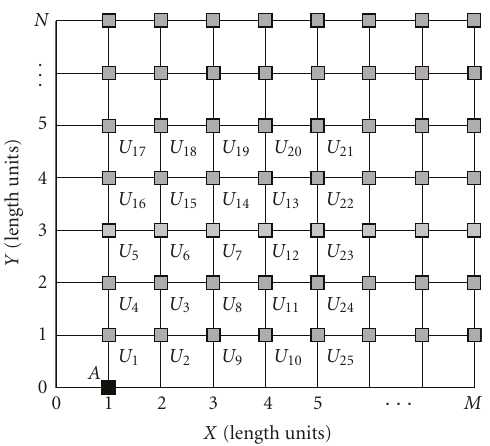
Figure 1: Schematic example of Kcdlocation